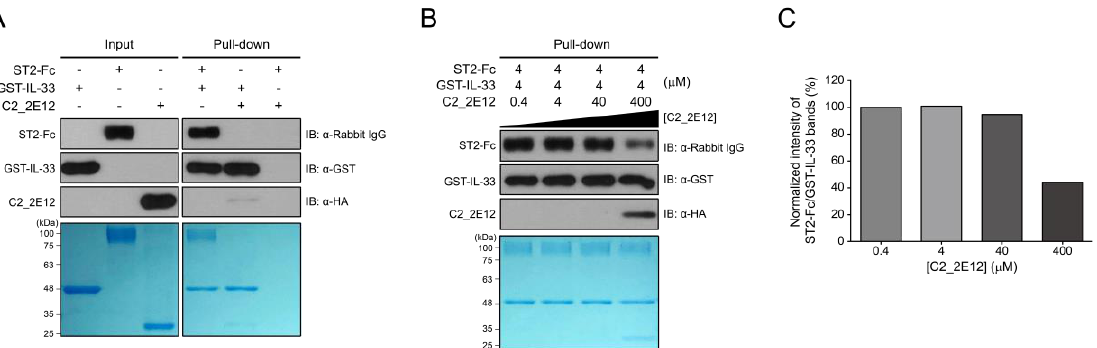
Figure 3. Interfering with IL-33 and suppressor of tumorigenicity 2 (ST2) complex formation by